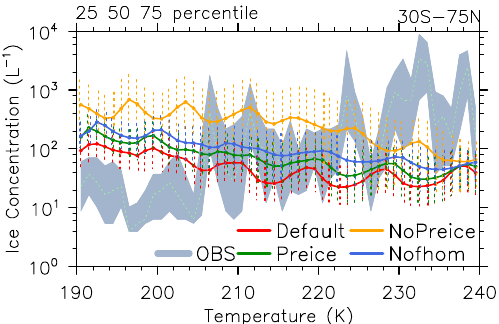
Figure 4. In-cloud ice crystal number concentration ( N i , L − 1 ) ver- sus temperature for Default, Preice, Nofhom and NoPreice exper- iments. Model results are sampled every 3h over tropical, mid- latitude and Arctic regions including the observation locations re- ported in Krämer et al. (2009). The 50th (solid line), 25th and 75th percentiles (error bar) are shown for each 1K temperature bin. The gray color indicates observations between 25th and 75th